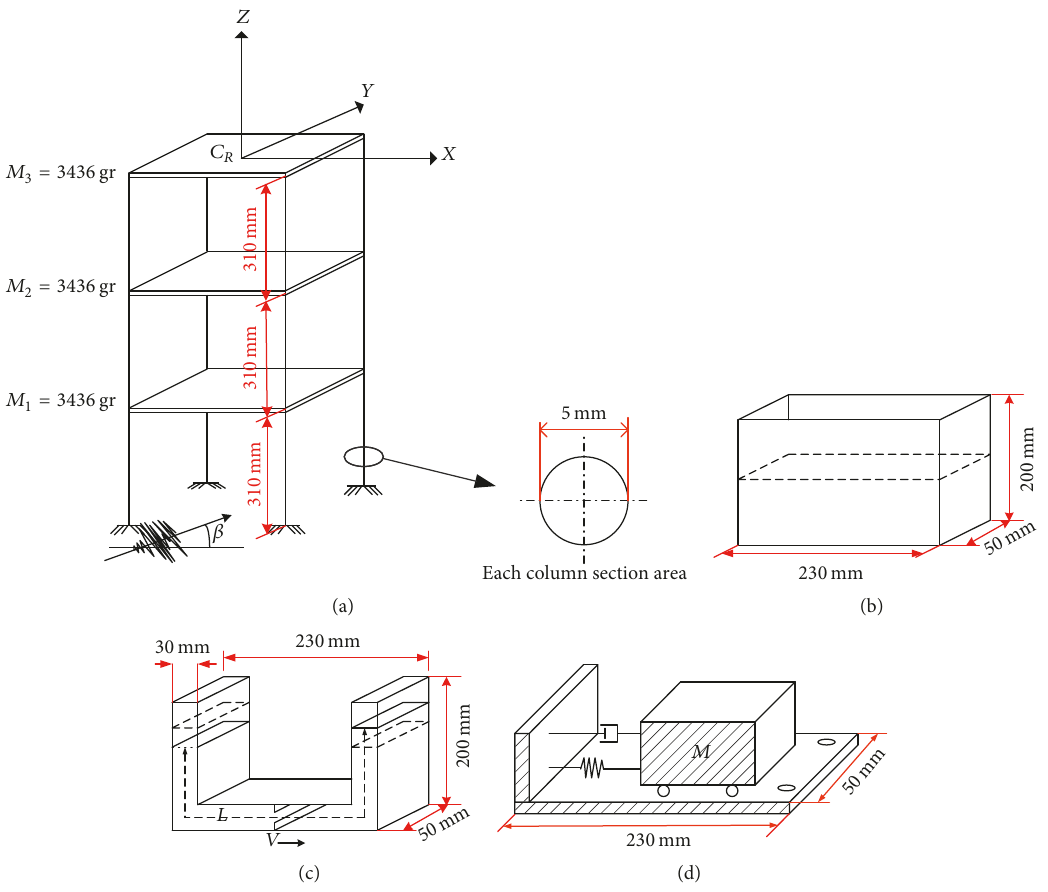
Figure 1: Experimental instruments and setup process, (a) building model, (b) TLD system, (c) TLCD system, and (d) TMD